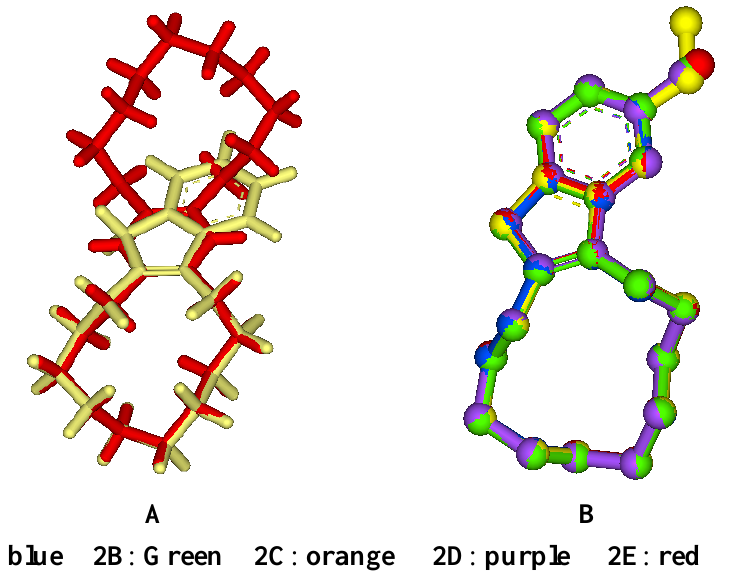
Figure 2. Superimposed diagrams of 2A – 2E and 2,3,5,6-bis( ortho -1,10-decylidene)- dihydropyrazine.